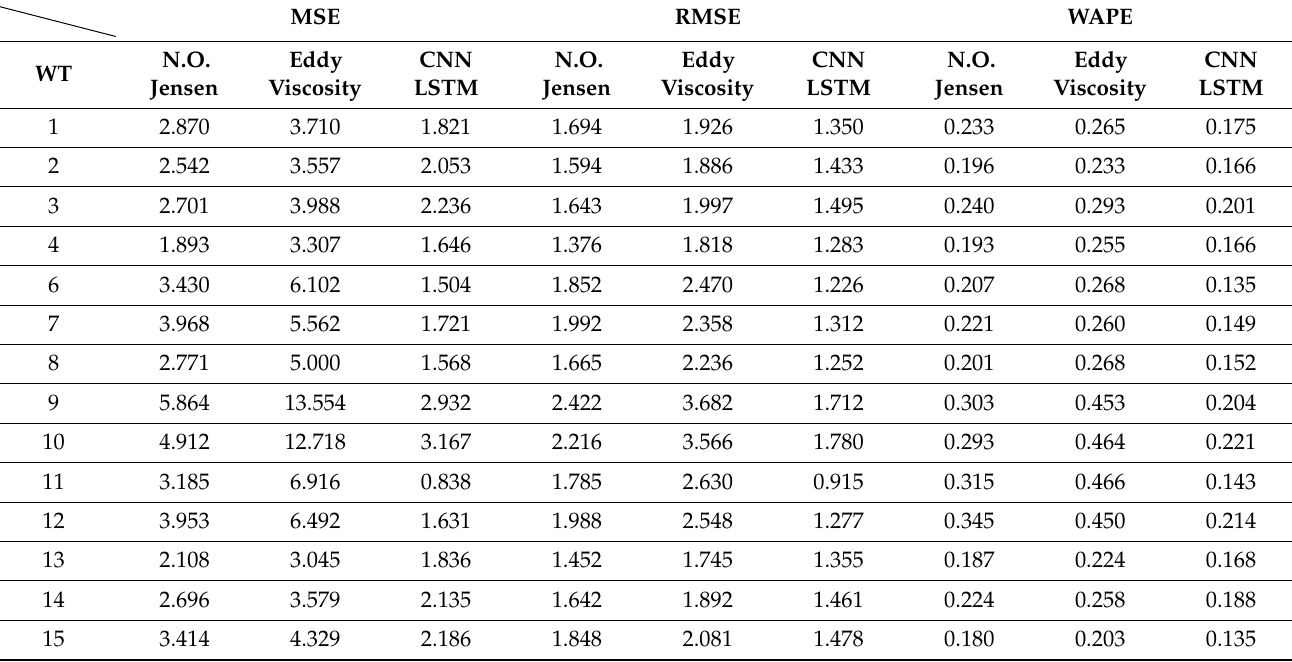
Table 6. Comparison of wake error caused by wind turbine No. 5.